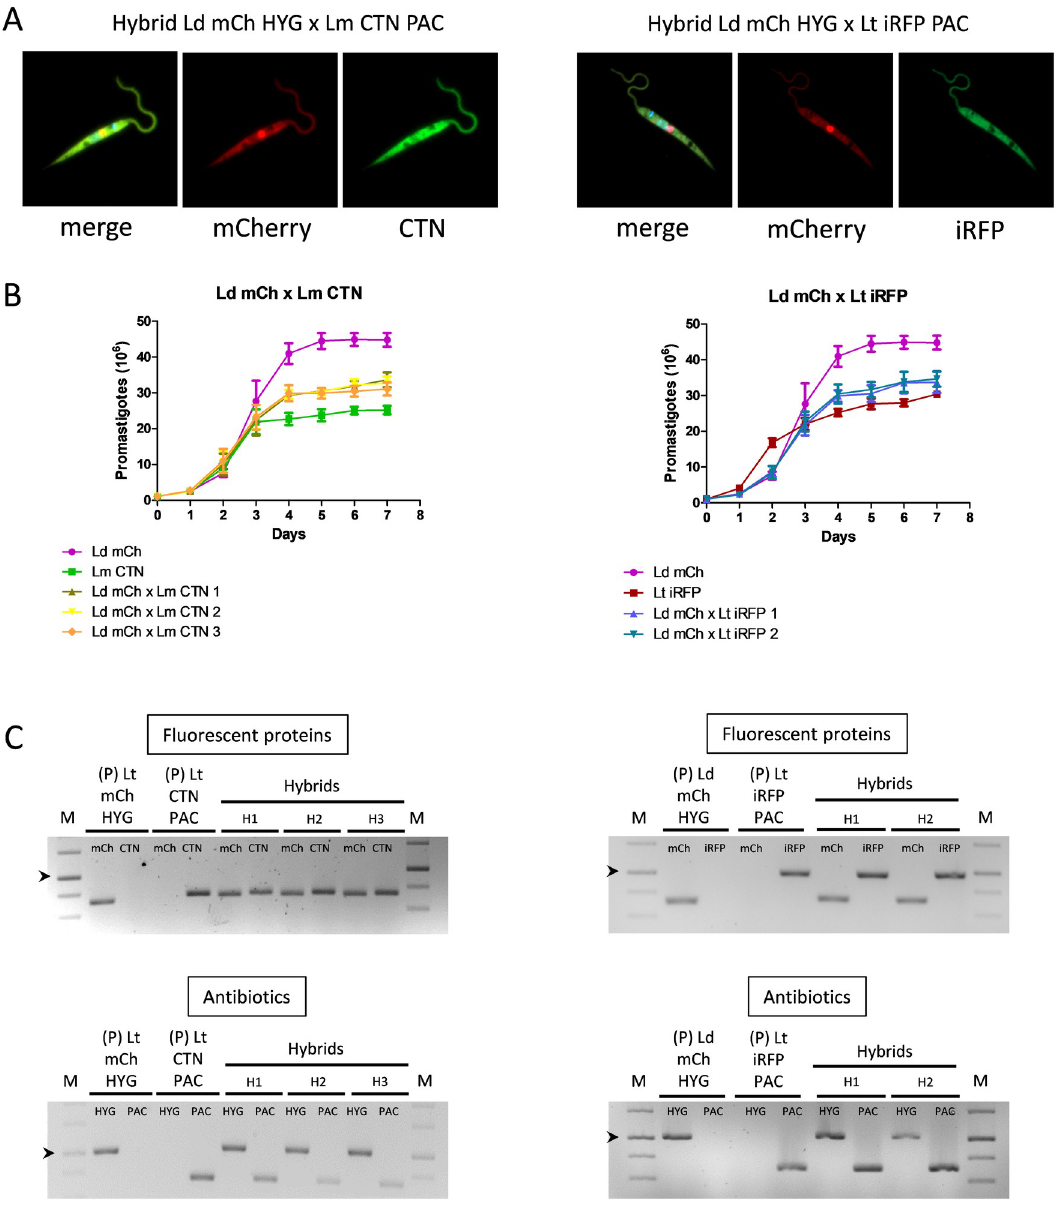
Fig 3. Characterization of interspecific hybrids. (A, left panel) Representative merged images of confocal microscopy and fluorescence emission in the mCh (561 nm) and CTN (488 nm) channels of one hybrid clone obtained after the outcrossing of L . donovani mCh HYG x L . major CTN PAC (Ld mCH HYG x Lm CTN PAC. (A, right panel) Representative merged images of confocal microscopy and fluorescence emission in the mCh (561 nm) and iRFP (640 nm) channels of one hybrid clone obtained after the outcrossing of L . donovani mCh HYG x L . tropica iRFP PAC (Ld mCH HYG x Lt iRFP PAC. (B, left panel) Growth curves (number of promastigotes in culture during 7 days) of the parental strains L . donovani mCh HYG (Ld mCh) and L . major CTN PAC (Lm CTN) and the interspecies hybrids Ld mCh x Lm CTN 1, 2 and 3. (B, right panel) Growth curves (number of promastigotes in culture during 7 days) of the parental strains L . donovani mCh HYG (Ld mCh) and L . tropica iRFP PAC (Lt iRFP), and the interspecies hybrids Ld mCh x Lt iRFP 1 and 2. (C, left panel) Agarose gels of the electrophoresis of the PCR products obtained after the amplification of the genes encoding fluorescent proteins (mCh and CTN) and antibiotic resistance (HYG or PAC) in the parental strains (P) and in the three interspecies hybrids (H) obtained after the outcrossing of L . donovani mCh HYG x L . major CTN PAC. (C, right panel) Agarose gels of the electrophoresis of the PCR products obtained after the amplification of the genes encoding fluorescent proteins (mCh and iRFP) and antibiotic resistance (HYG or PAC) in the parental strains (P) and in the two interspecies hybrids (H) resulting from the outcrossing of L . donovani mCh HYG x L . tropica iRFP PAC. The arrowheads indicate the 1000 bp band in the DNA molecular weight marker (M).